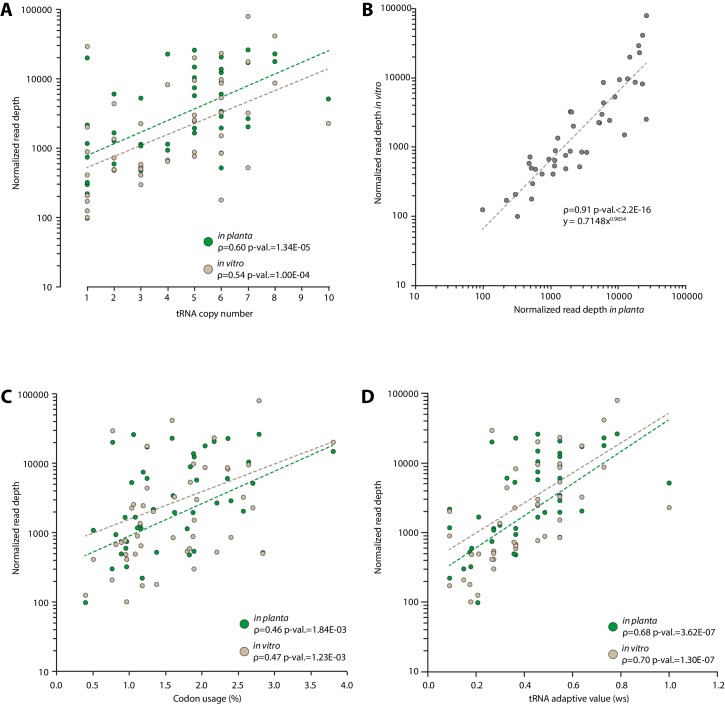
Experimental determination of S. sclerotiorum tRNA accumulation supports a good correlation between genomic copy numbers and tRNA accumulation.The accumulation of tRNA transcripts was determined by sequencing small RNAs of S. sclerotiorum grown in vitro and in planta. (A) Normalized read depth correlated exponentially with tRNA copy number for each tRNA species both in vitro and in planta. (B) A comparison of tRNA transcripts accumulation in vitro and in planta. Correlation of tRNA transcripts accumulation with codon usage (C) and tRNA adaptive value (D) calculated as described in dos Reis et al. (2004). The exponential regression of the data is shown as a dotted line. The Spearman rank correlation coefficient ρ and the p-value for Spearman’s test are given.